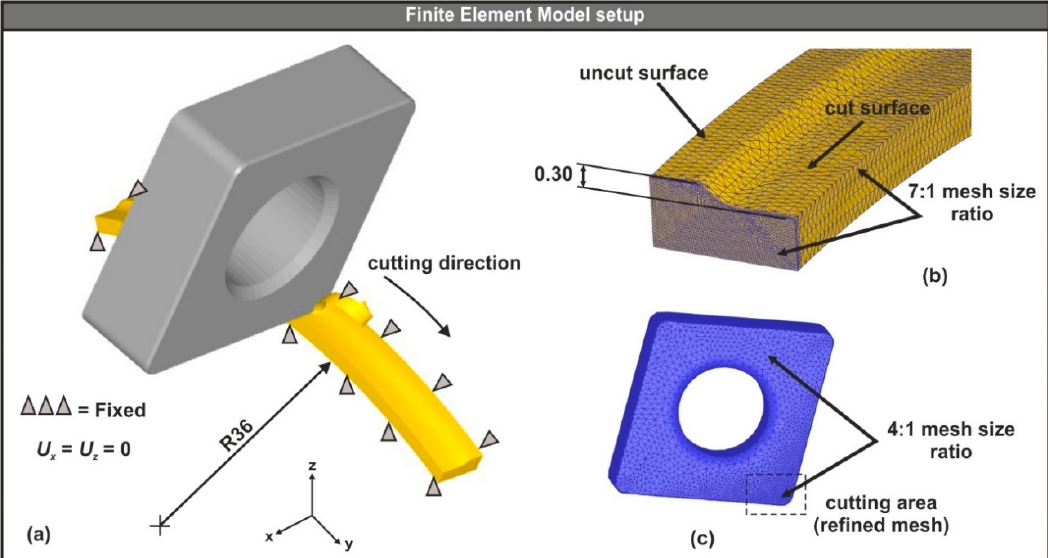
Figure 4. ( a ) The FE model setup, ( b ) the analysis domain, and ( c ) the meshed tool.